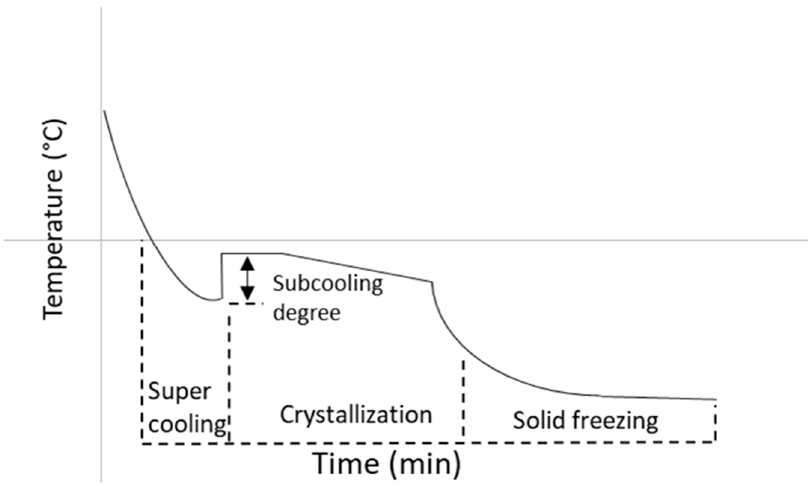
Figure 10. Schematic of typical freezing curve.